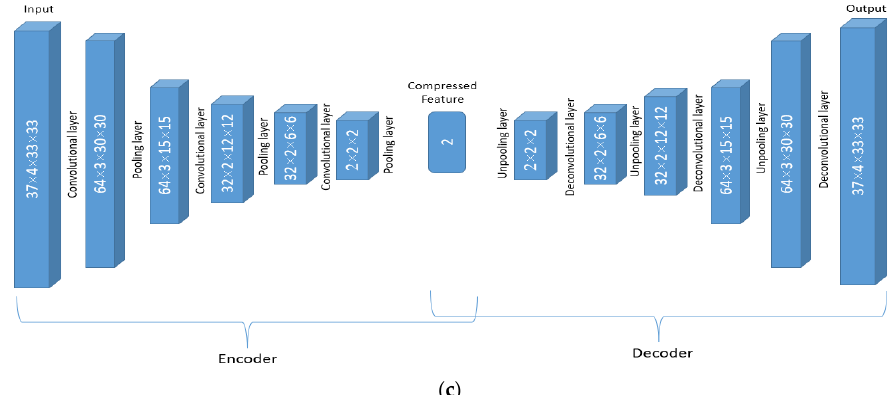
Figure 5. The structure for the adjusted auto-encoder network with the number of compressed features (num) as 8 ( a ), 4 ( b ), and 2 ( c ). After the new structures for DL Interim filters are derived, we retrain each network 200 times, although all the networks converge after 100 iterations. It should be emphasized that the randomness in the TCNET training process makes the training results different for different training sessions. However, the overall trends in the results should be similar if not the same. As same as being processed above, 19 variables, i.e., pv2, pv4, pv5, q1, u4, u7, v1, v2, vo2, vo7, w4, d1, d2, d4, t2, t3, t4, z1, and o32 are zero features, i.e., they contain